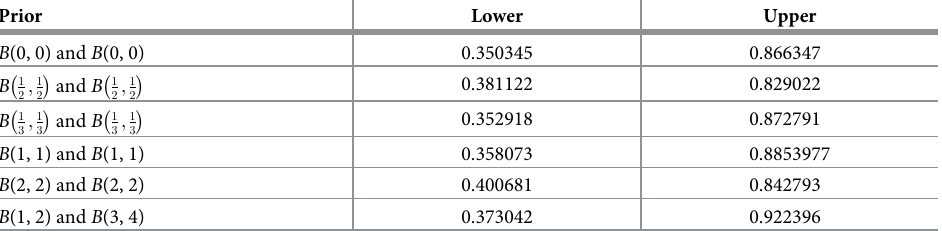
Table 7. 95% highest posterior density credible intervals for the pestis secunda plague data from Table 3 for vari- ous priors. Prior Lower Upper B (0, 0) and B (0, 0) 0.350345